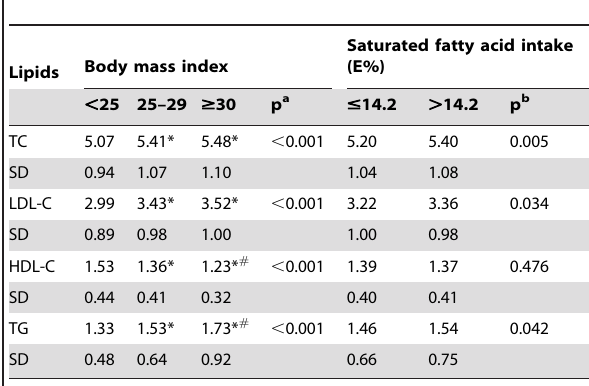
Table 4. Mean serum lipid levels (mmol/l), according to body mass index and saturated fatty acid